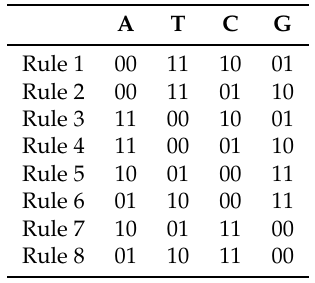
Table 1. DNA encode/decode rules.